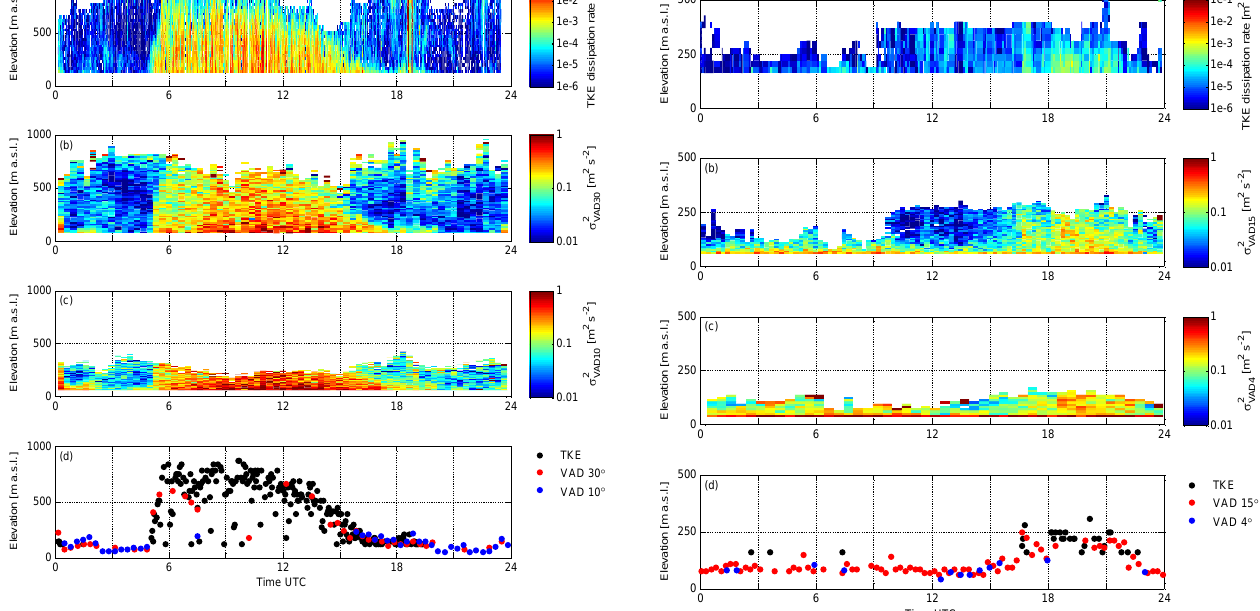
Figure 5. Diurnal variation at Limassol on 17 September 2013 of (a) TKE dissipation rate, (b) σ 2 from 30 ◦ elevation angle VAD, VAD (c) σ 2 from 10 ◦ elevation angle VAD and (d) MLH. VAD